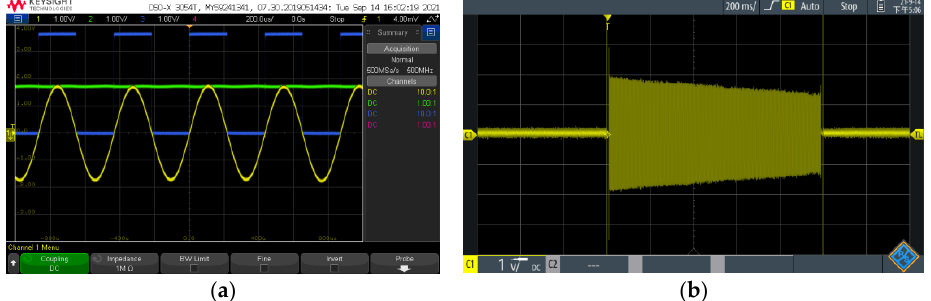
Figure 13. ( a ) Simulated FID signal, shaped signal, and envelope, ( b ) Measured FID signal.